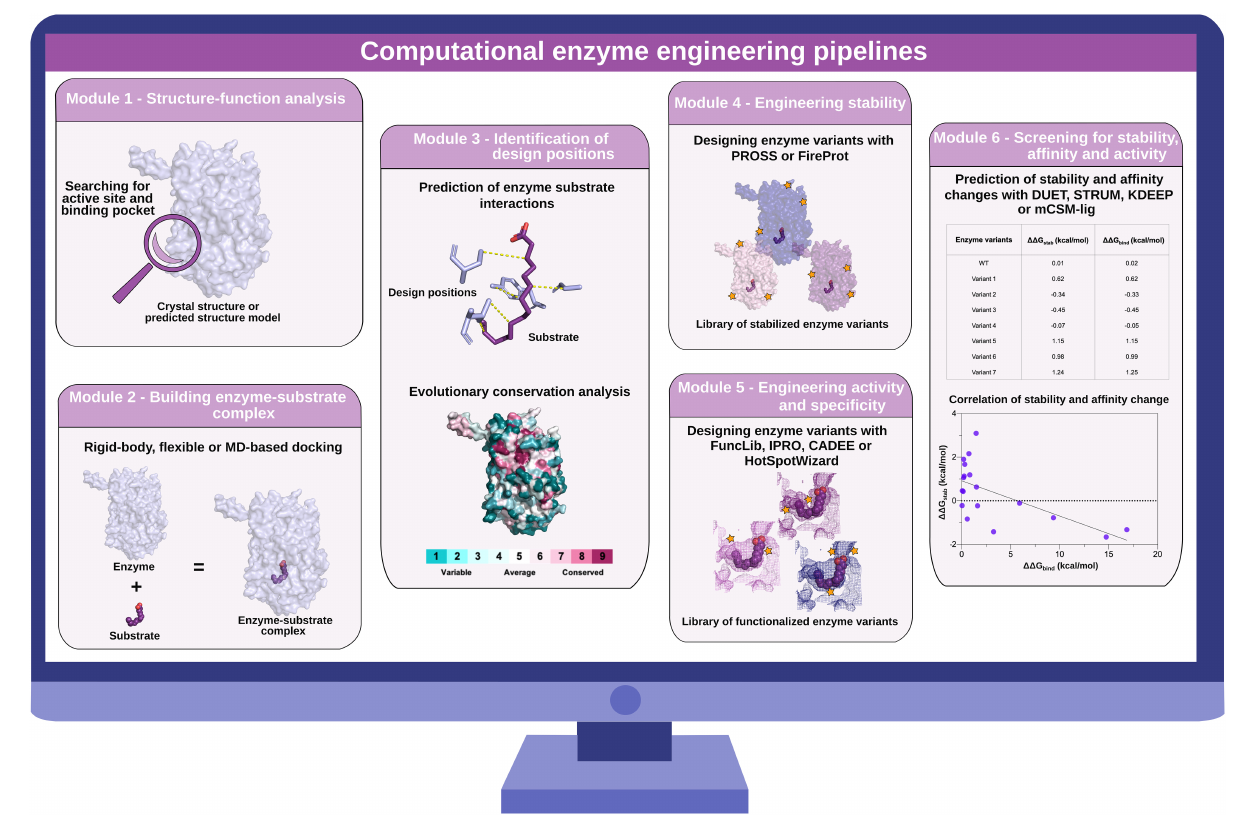
FIGURE 2 | Computational enzyme engineering pipelines. Module 1: structure–function analysis to identify active site and substrate-binding pocket. Module 2: building enzyme–substrate complexes with molecular docking approaches. Module 3: identification of design positions for the subsequent sequence design. Module 4: engineering stability of enzymes with PROSS and FireProt. Module 5: engineering activity and specificity of enzymes with FuncLib, IPRO, CADEE, and HotSpotWizard. Module 6: screening for stability, affinity, and activity changes with DUET, STRUM, KDEEP, and